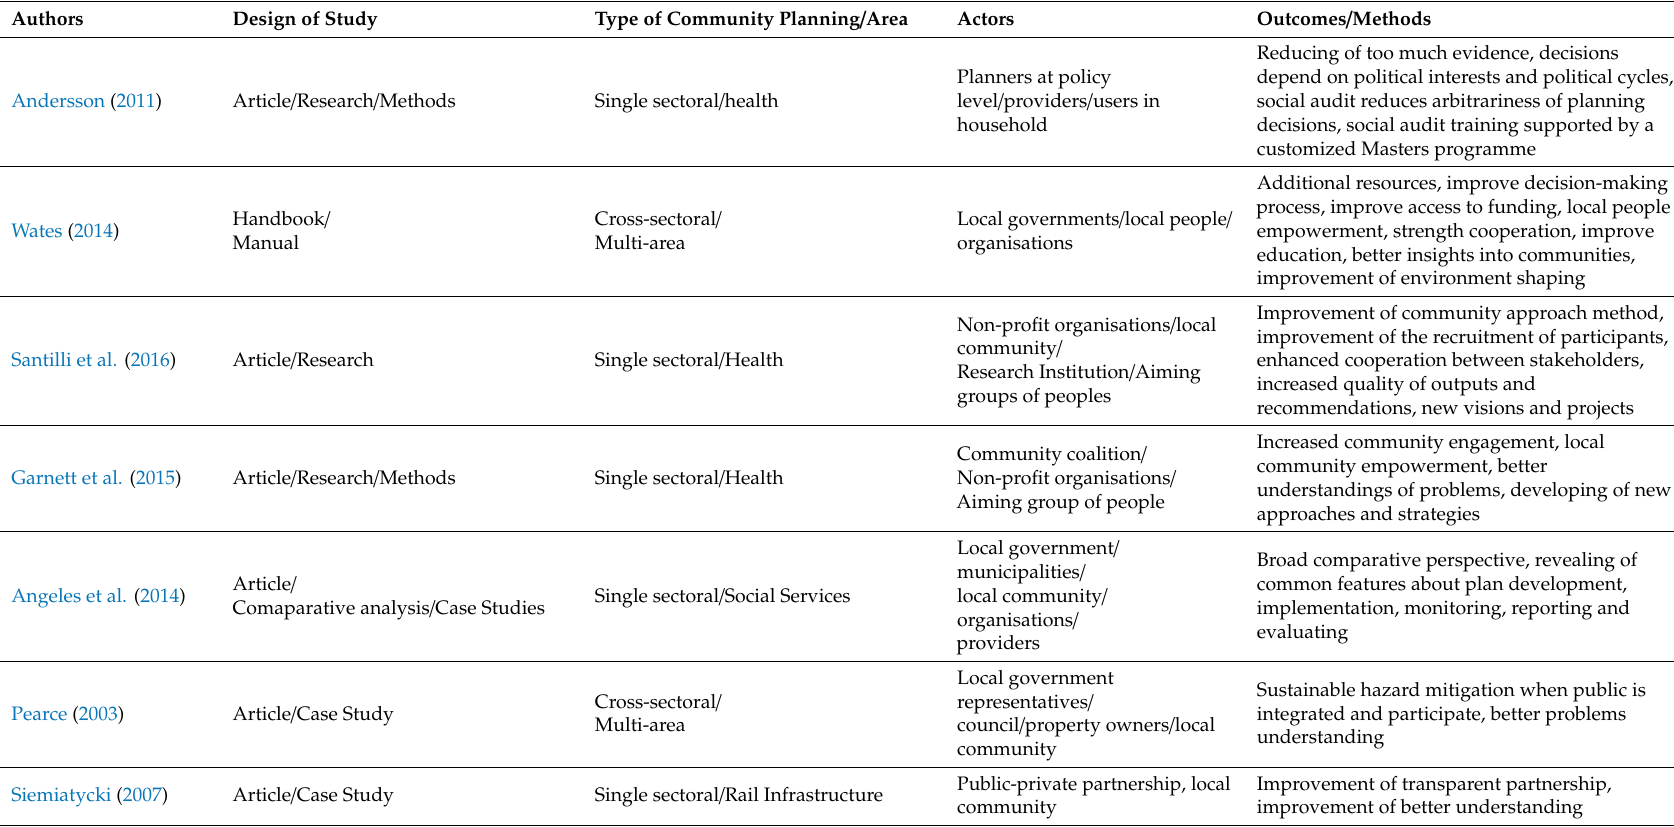
Table 3. Structured Literature overview summary—community planning in current